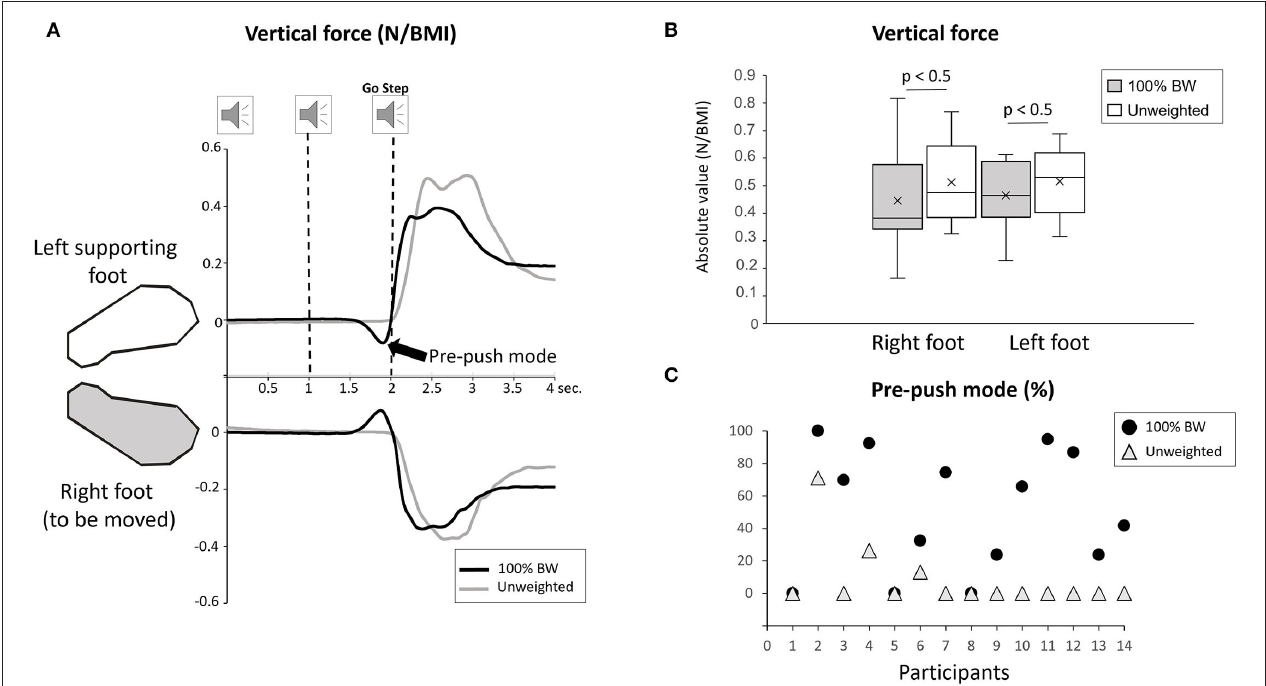
FIGURE 3 | (A) Mean vertical ground reaction force during 100% BW and unweighted conditions under the right and the left feet for one participant in the stepping task. The participant is stepping with the right foot moving forwards. This figure shows the loading/unloading mechanism. The increase signifies a loading of the weight on the supporting foot, and the decrease represents a simultaneous unloading of the foot to be moved. Note in black the pre-push mode of body weight transfer. Speakers represent the onset of the 3-sound signals with 1-s interval. (B) Whisker plot of the mean amplitude (in absolute value) of the left and right vertical forces during 100% BW and unweighted conditions for all participants (error bars are standard deviation across participants). (C) Percentage of the occurrence of the pre-push mode for each participant in 100% BW and unweighted